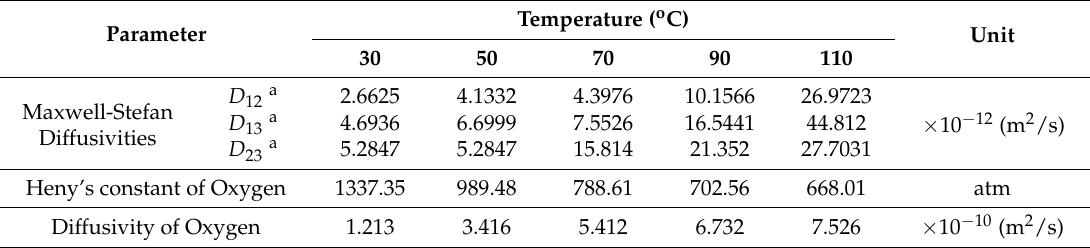
Table 2. Transport and dissolution properties of ions. Adapted with copyright permission from Yoo et al. [44], with permission from